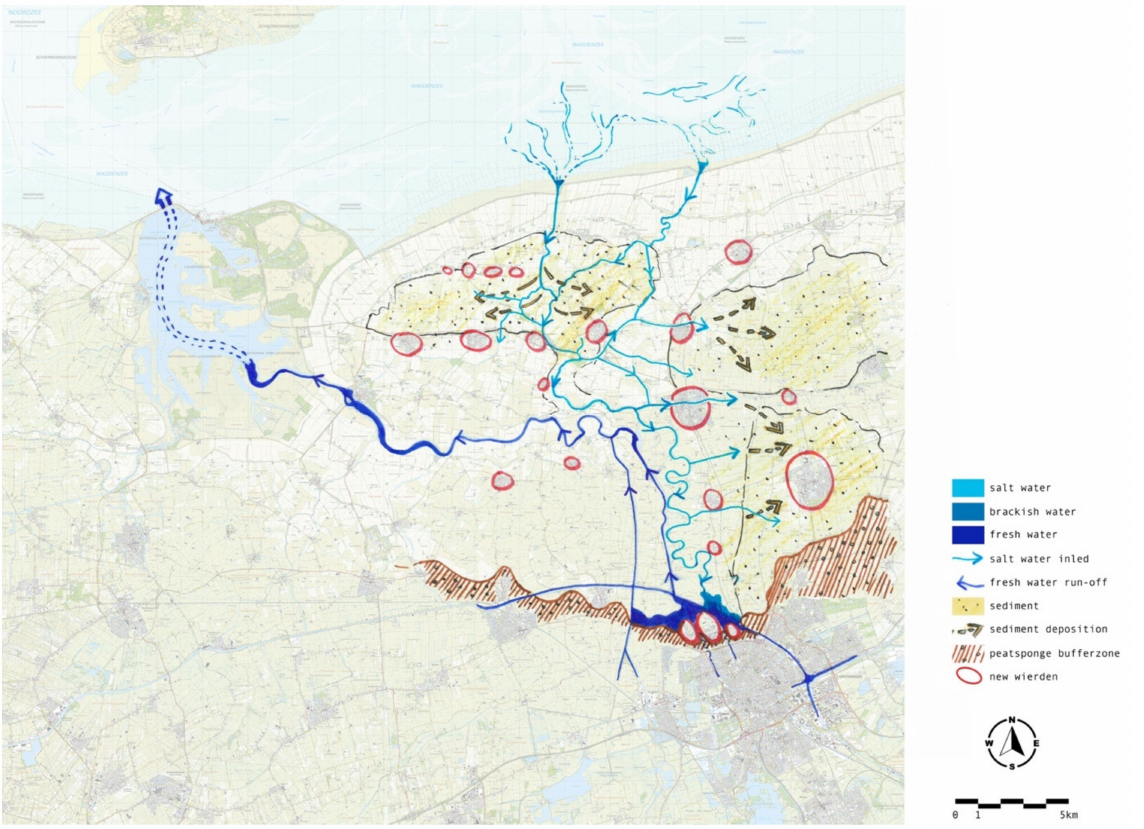
Figure 14. The adjusted water